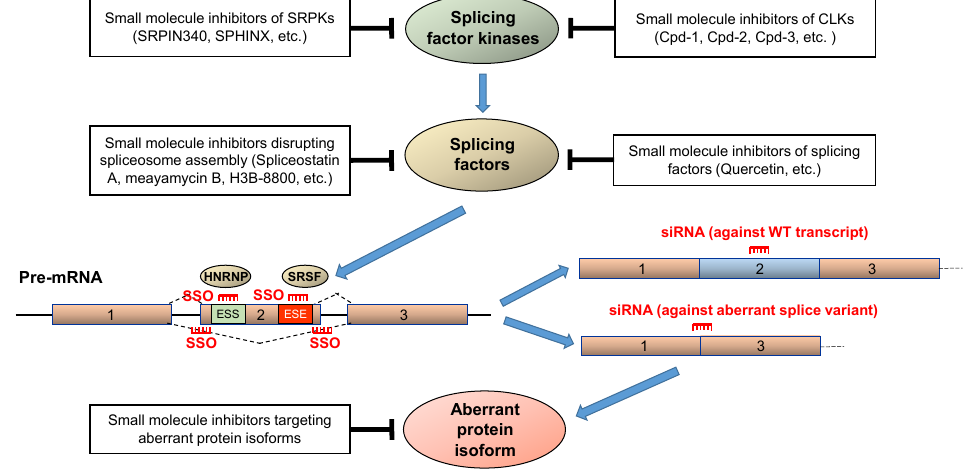
Figure 5. Potential therapeutic approaches to correct splicing errors. Small molecule inhibitors (Cpd-1, Cpd-2, Cpd-3, SRPIN340, SPHINX) can be used to block the activity of splicing factor kinases (CLKs and SRPKs) thereby reversing aberrant mRNA splicing. Small molecule inhibitors of splicing factors (Spliceostatin A, Meayamycin B, H3B-8800, Quercetin) can reverse aberrant splicing by blocking spliceosome assembly or directly targeting splicing factors. Splice switching oligonucleotides (SSOs) can prevent SRSF and HNRNP proteins from interacting with exon splicing enhancers (ESEs) and exonic splicing silencers (ESSs) located on the pre-mRNA, respectively. SSOs targeting exon-intron junctions can disrupt alternative splicing. Future small molecules can be developed to specifically target aberrant protein isoforms. All of these strategies may be used to correct splicing errors and overcome drug resistance. See text for corresponding